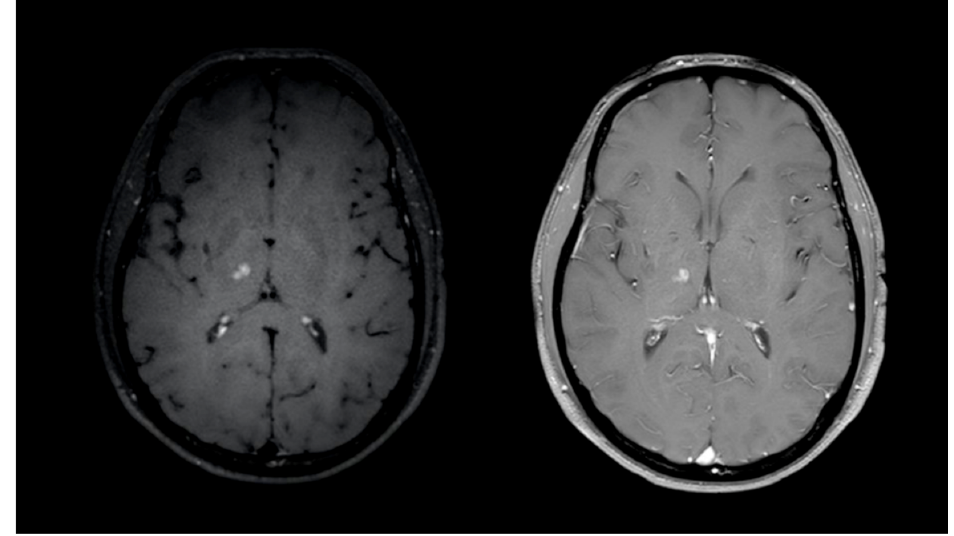
Figure 1. Left : lesion in the black blood sequence. Right : corresponding axial conventional CE T1 slice with identical lesion.